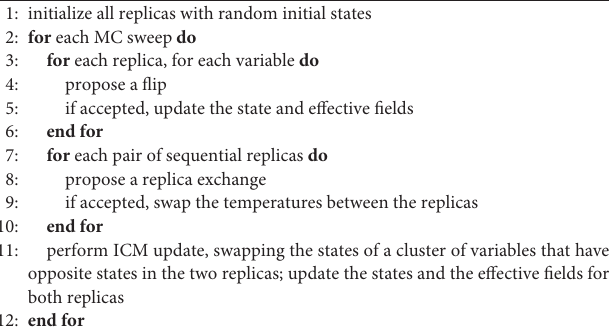
Algorithm 3 Parallel Tempering with Isoenergetic Cluster Moves